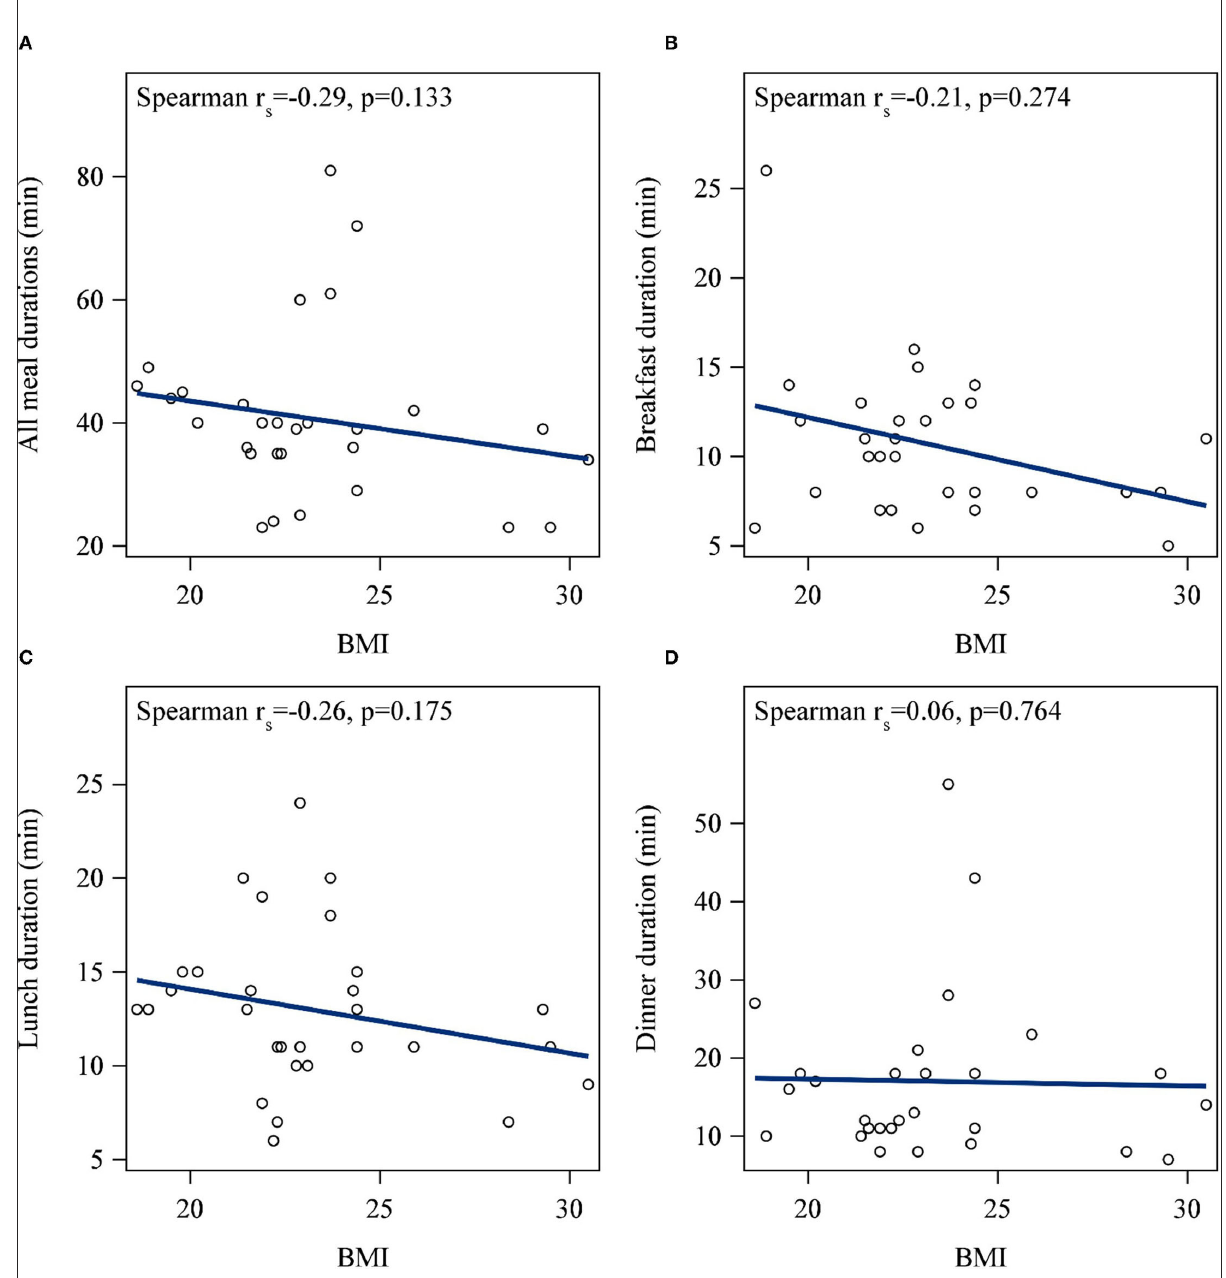
FIGURE3 Correlations between energy intake and the rate of eating for (A) all meals summed, (B) breakfast, (C) lunch, and (D) dinner. The rate of eating was positively associated with energy intake for each meal, and the total across all meals (all p < 0.05).